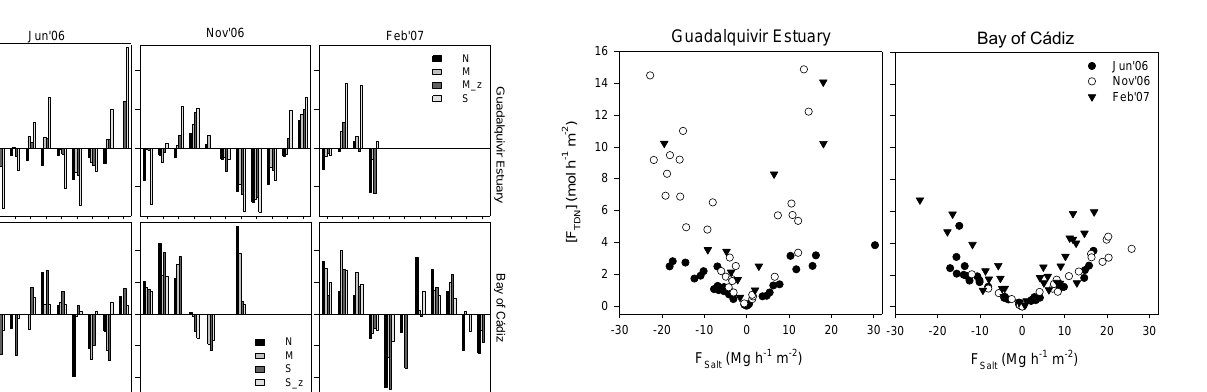
Fig. 7. Instantaneous salinity fluxes ( F Salt ) versus the absolute mag- nitude of instantaneous total dissolved nitrogen fluxes ([ F TDN ]) de- termined in the two study areas (Guadalquivir estuary and the Bay of C´adiz) in the three different sampling periods: June 2006 (black circles), November 2006 (white circles) and February 2007 (black